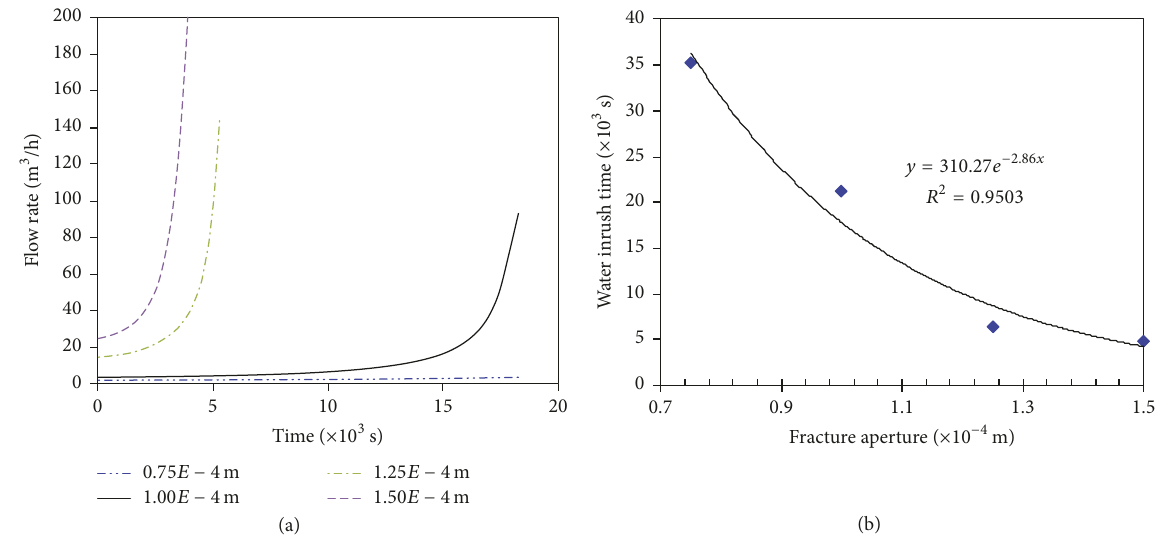
Figure 27: Impact of absolute aperture on water flow rate (a) and inrush time